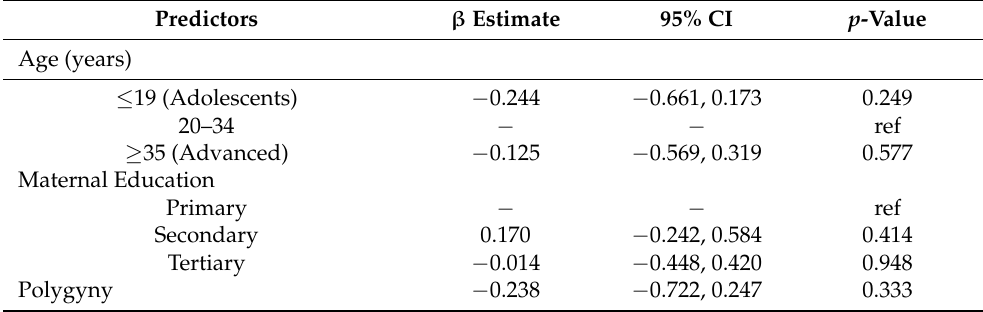
Table A8. Results of multivariate regression for the sum of HCC and HCNC.